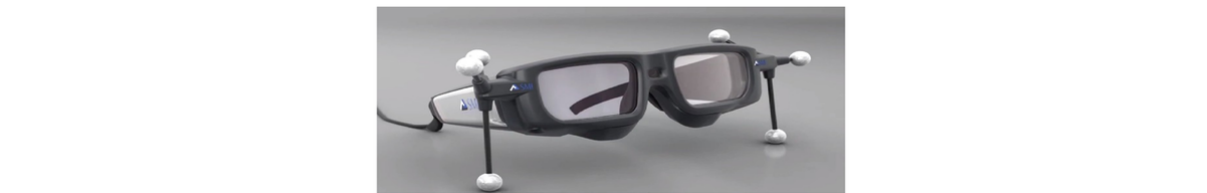
Figure 3. SMI Eye Tracking Glasses with 3D reflective markers.